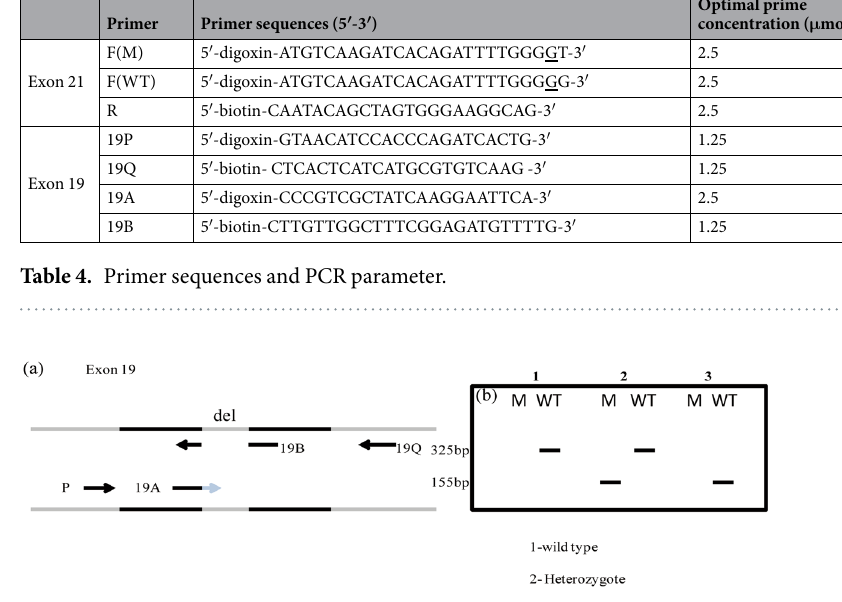
The primers design for L858R and delE746-A750 in EGFR gene. forward primers are allele specific since the nucleotide at their 3 ′ terminus corresponds to the SNP site. (Table 4). To ensure the specificity of the primers, an additional mismatch at the penultimate or antepenultimate nucleotide of the 3 ′ terminus of allele specific forward primers was introduced 30 . For testing and proving the specificity of allele-specific PCR primers, plasmid was constructed containing L858R homozygous mutation and the sequences of plasmid was confirmed by sequencing. For detecting the 15-bp deletion in exon19 of EGFR (codons 746–750), two tubes bi-directional PCR allele-specific amplification (Bi-PASA) assay was designed instead of the traditional one tube 31 , which can detect both possible nucleotide deletions (c.2235_2249del15 and c.2236_2250del15) that give rise to an E746-A750del protein change. The Bi-PASA reaction contains four primers: two specific primers: A and B, and two outer prim- ers: P and Q (Table 4). The 3 ′ end of inner primer A are complementary to a part of the deletion sequence and the deletion allele primer B are complementary to the mutant DNA sequence containing the deletion in opposite direction. The two outer primers (P and Q) were placed on the opposing strands at predefined bases. A two-tube (M tube and WT tube) Bi-PASA yields two overlapping fragments according to the genotype. AQ and PB are present in a heterozygote individual, whereas AQ is only produced in wild-type homozygote and PB only in homozygous mutant samples (Fig. 5). The two-tube PCR reactions allow distinction between different genotypes using the same DNA template. The M tube contains primer P and the deletion mutant primer B, intending to detect the deletion sequence PB. The WT tube contains primer Q and the inner primer A, aiming to detect the wild-type sequence AQ. Similarly, for testing and proving the specificity of the primers, plasmid was constructed containing delE746-A750 homozygous mutation and the sequence of plasmid was confirmed by sequencing. PCR amplification.